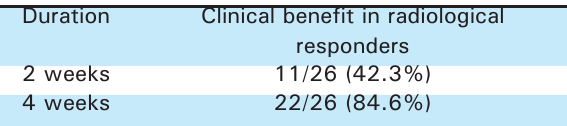
Table 3. Clinical bene fi t in NSCLC patients